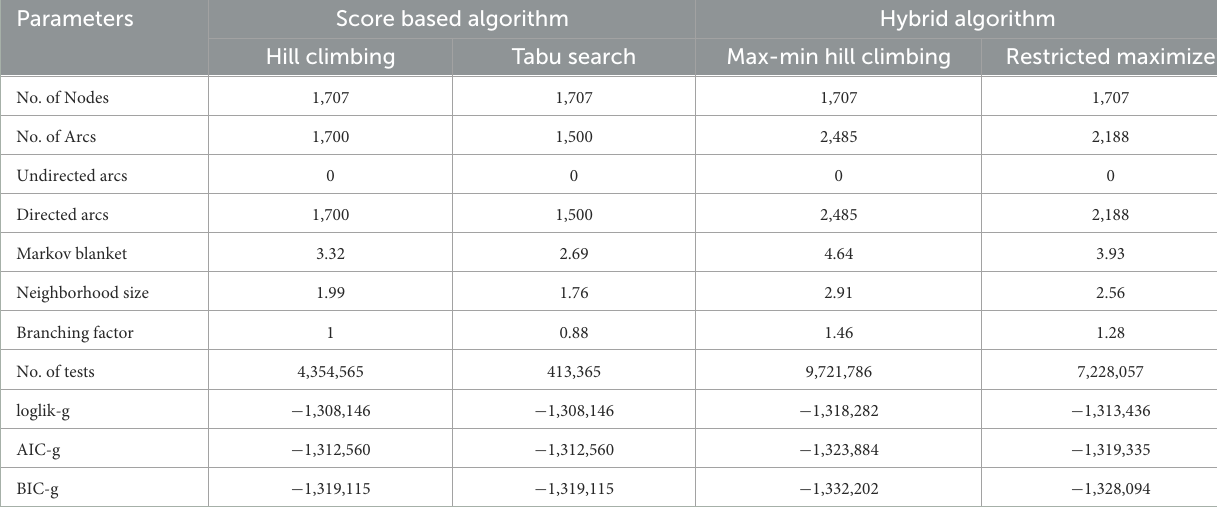
TABLE 2 Estimation of structural Bayesian network parameters with different algorithms.